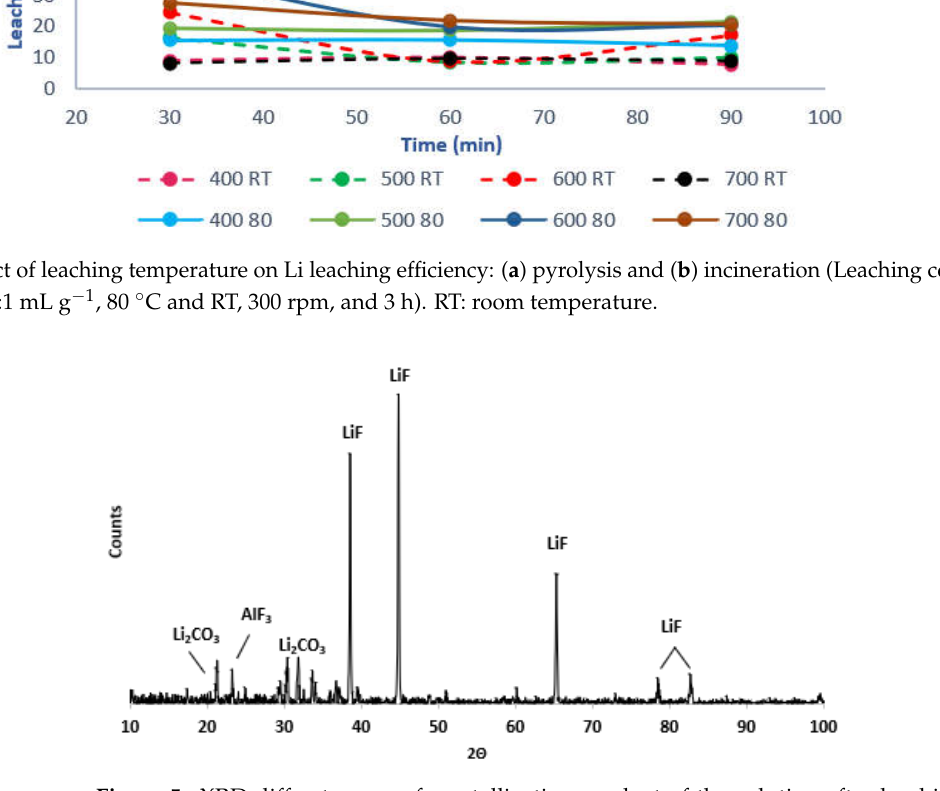
Figure 5. XRD diffractogram of crystallization product of the solution after leaching pyrolyzed sample (700 °C and 30 min).